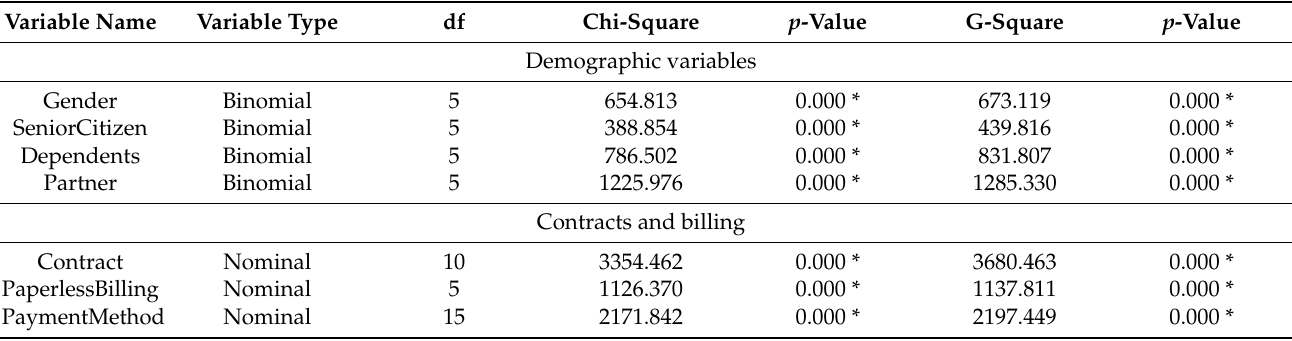
Table 3. Chi-square analysis for nominal